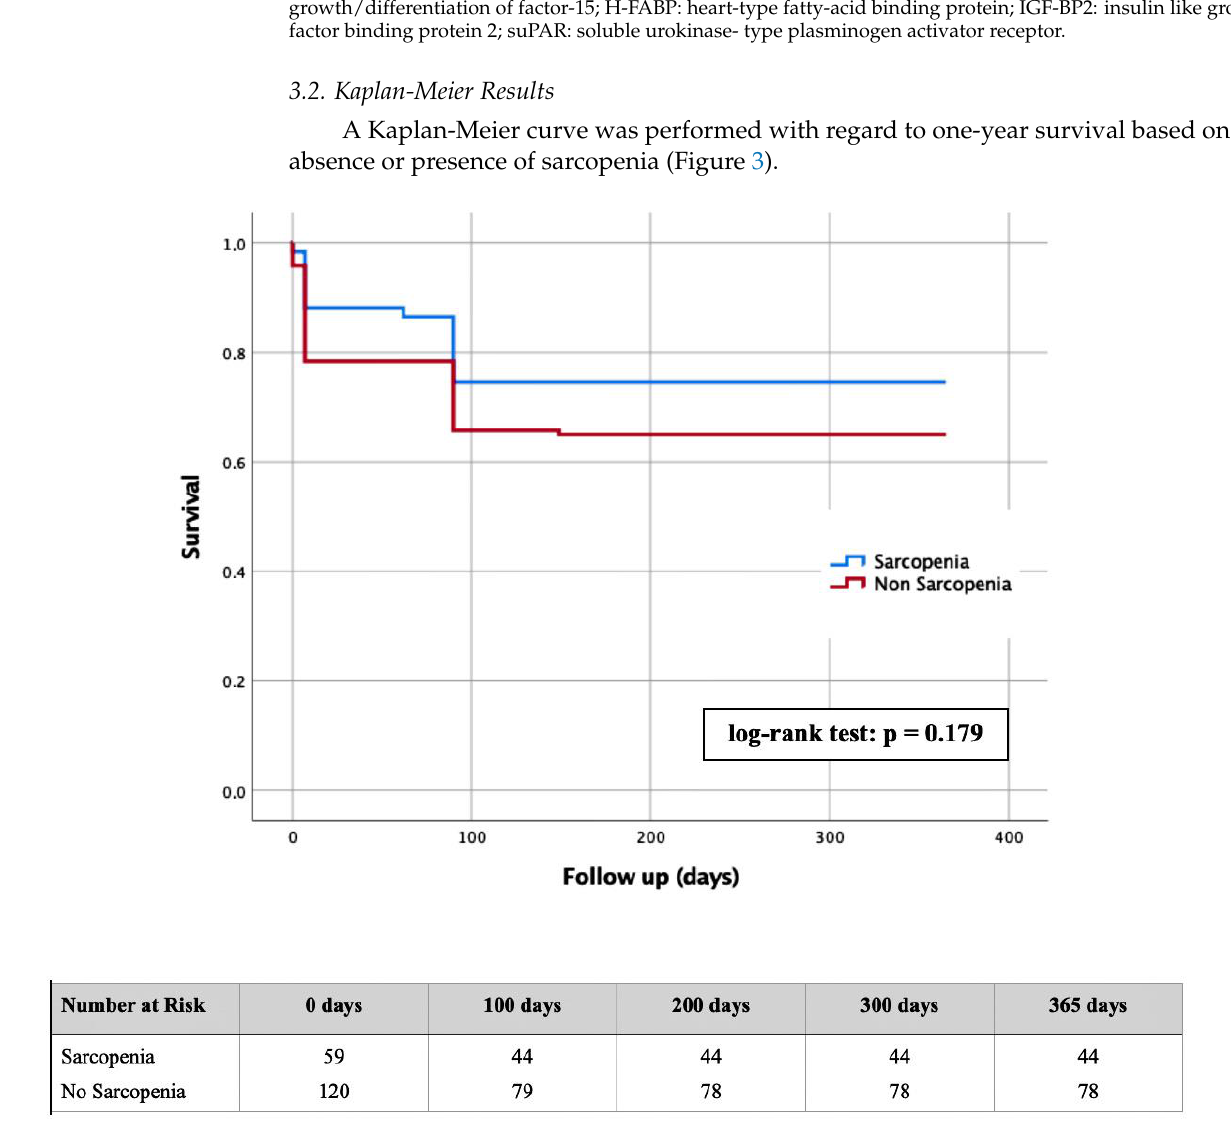
Figure 3. Kaplan-Meier curves with the corresponding number for the detection of one-year sur- vival based on the presence or absence of